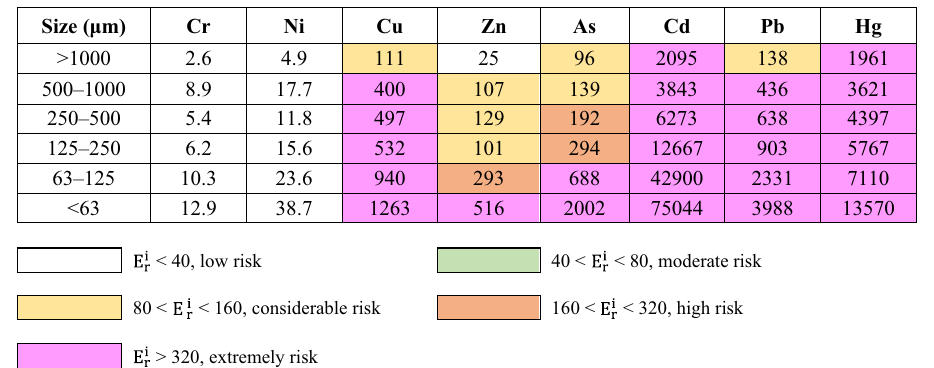
i r ) of PTEs in the different size of road deposited